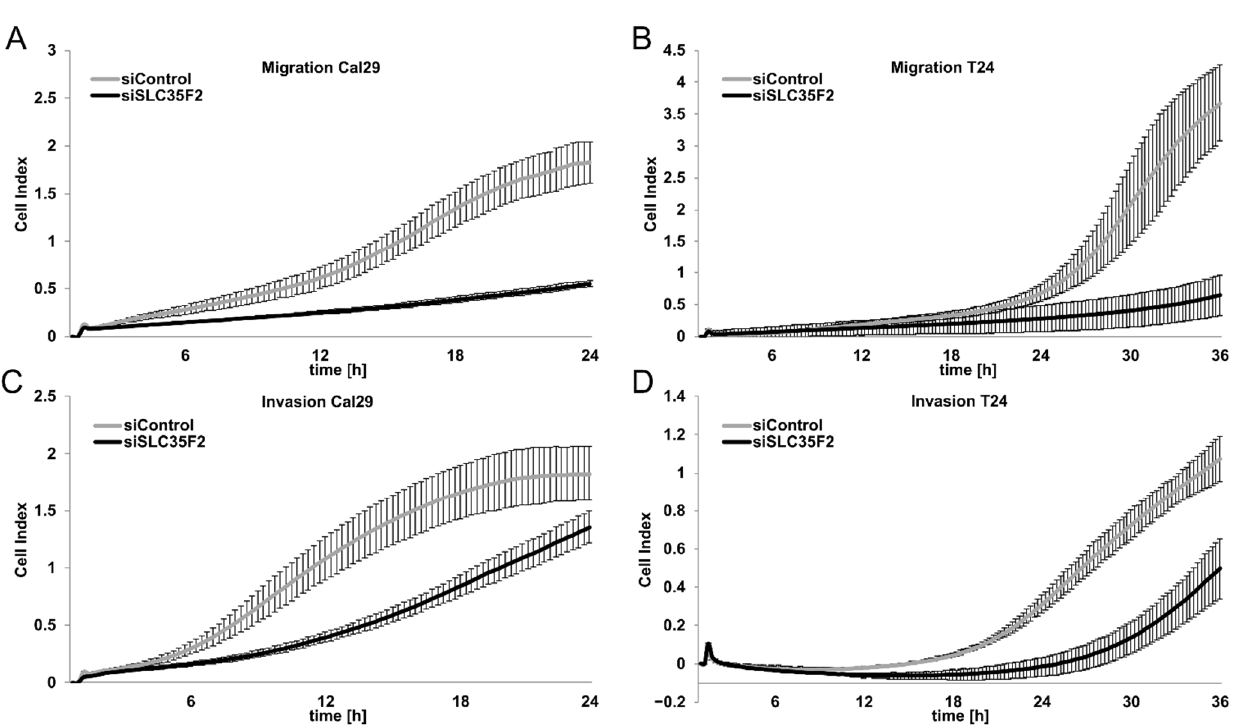
Figure 5. SLC35F5-dependent migration and invasion of bladder cancer cells. Migration of Cal29 ( A ) and T24 ( B ) is strongly reduced after siRNA knockdown of SLC35F2. The invasiveness of T24 ( C ) and Cal29 ( D ) was significantly reduced using 1:12 and 1:40 diluted Matrigel, respectively. Here, 20,000 cells were used for migration analysis and 40,000 cells were used for invasion analysis. The cell index reflects the amount of cells that pass the membrane between the upper and lower chamber, analysed by xCelligence real-time system.